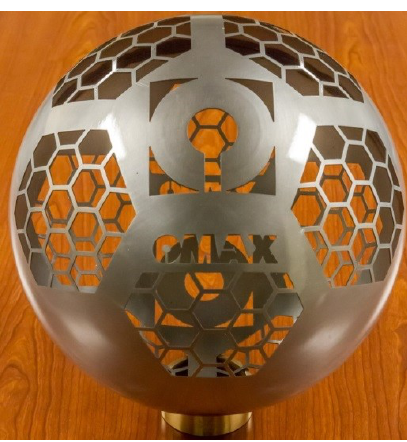
Figure 11: AWJ-machined soccer ball.